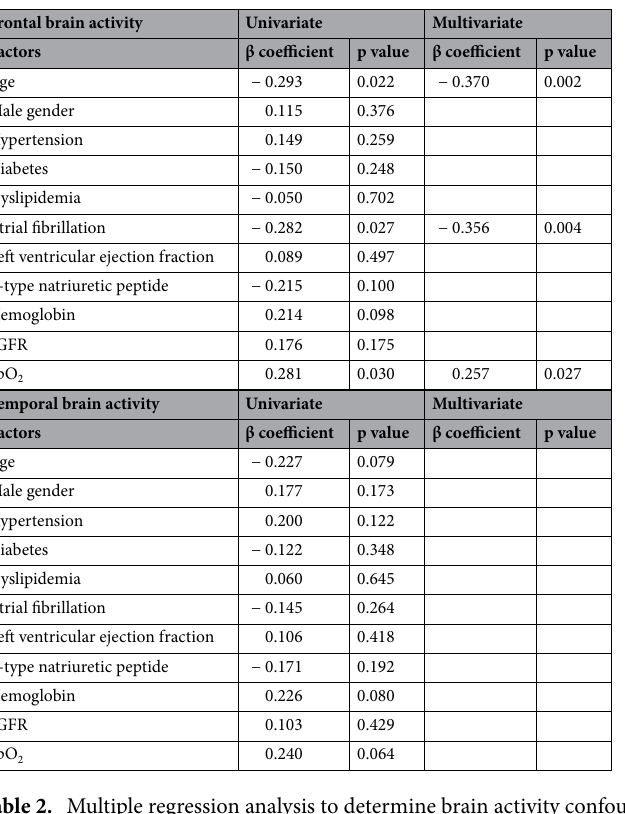
Table 2. Multiple regression analysis to determine brain activity confounding factors. eGFR, estimated glomerular filtration rate; SpO 2, percutaneous oxygen saturation.